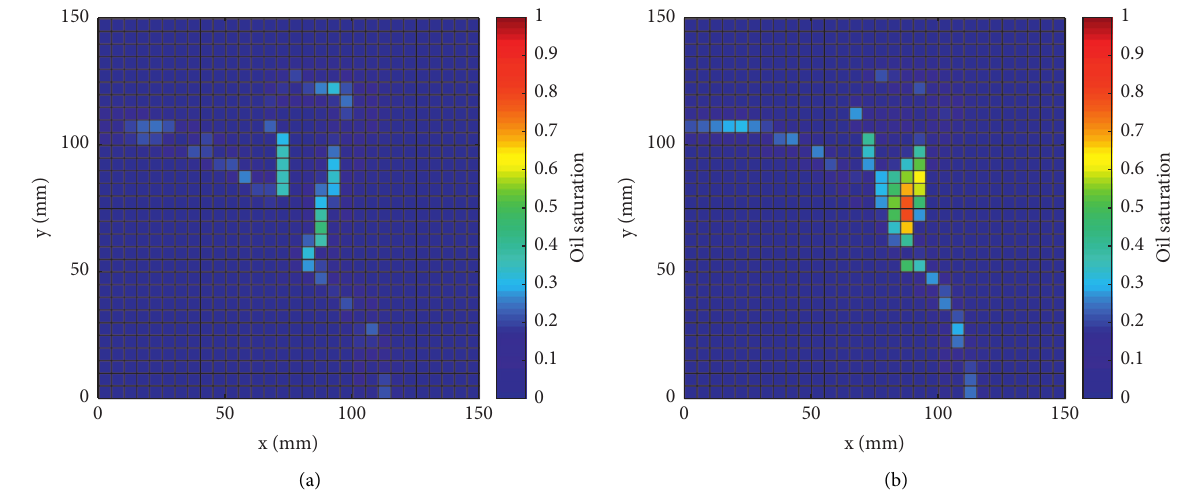
Figure 12: Oil saturation error profiles for (a) pIEDFM and (b) EDFM after 1800seconds of injection.